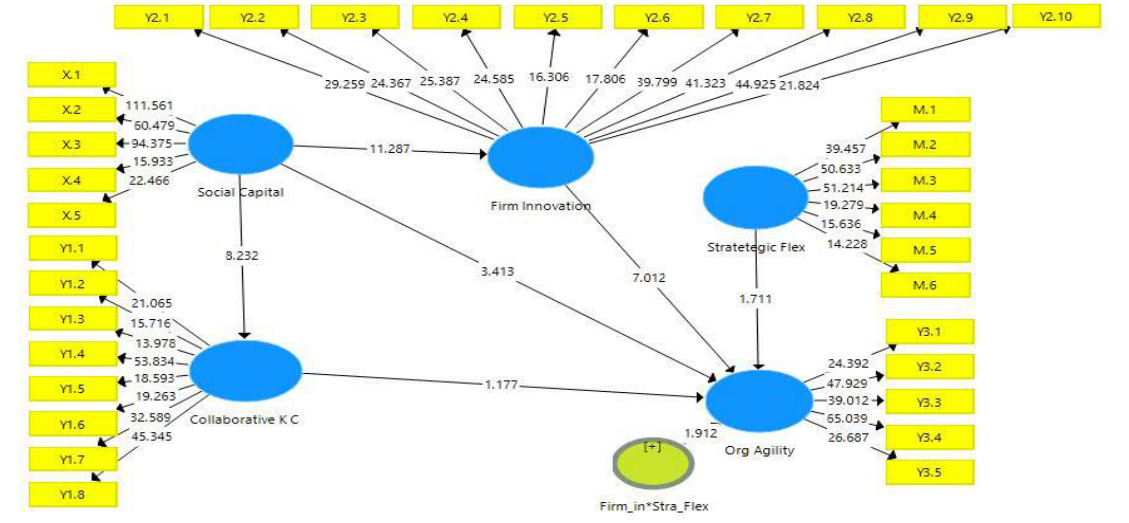
Figure 2. Output Analysis.